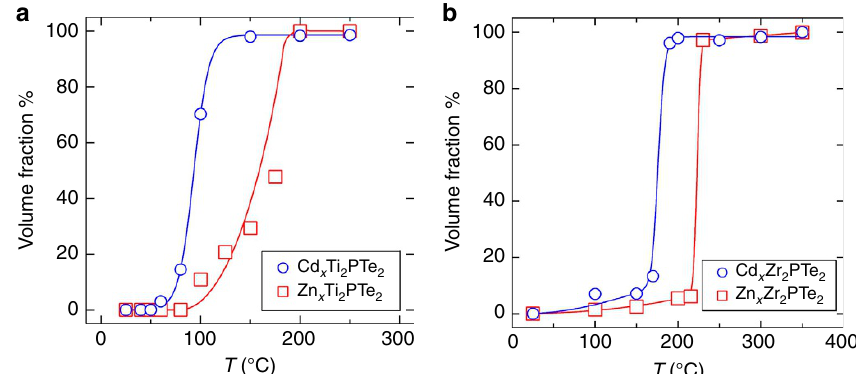
Figure 6 | Temperature-dependent intercalation yields for Ti 2 PTe 2 and Zr 2 PTe 2 . Reaction temperature dependence of the volume fraction of ( a ) M x Ti 2 PTe 2 and ( b ) M x Zr 2 PTe 2 where M ¼ Zn (red) and Cd (blue). Both the samples were heated together with and elemental metal (Zn or Cd) at various temperatures for 48h. The molar volume fraction was estimated from the Rietveld refinement. Solid lines are drawn as a guide for visualization. The error bars are smaller than the size of the